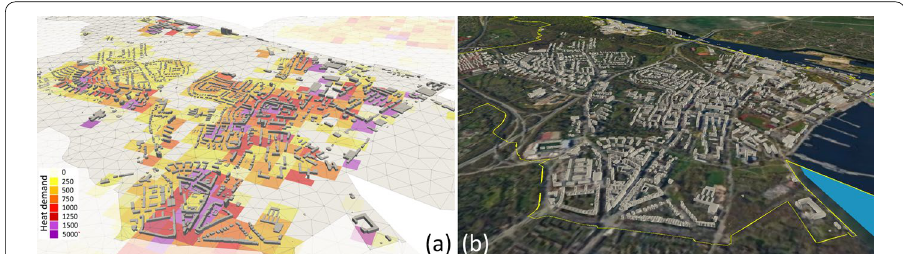
Fig. 5 Visualisation of building stock for a district in the city of Kiel. a Building models mapped onto a triangulated surface showing heat demand density (in MWh /( ha × a ) ) for the city of Kiel. b Building models shown on top of aerial imagery. The yellow boundary marks the city district of Kiel for which buildings have been